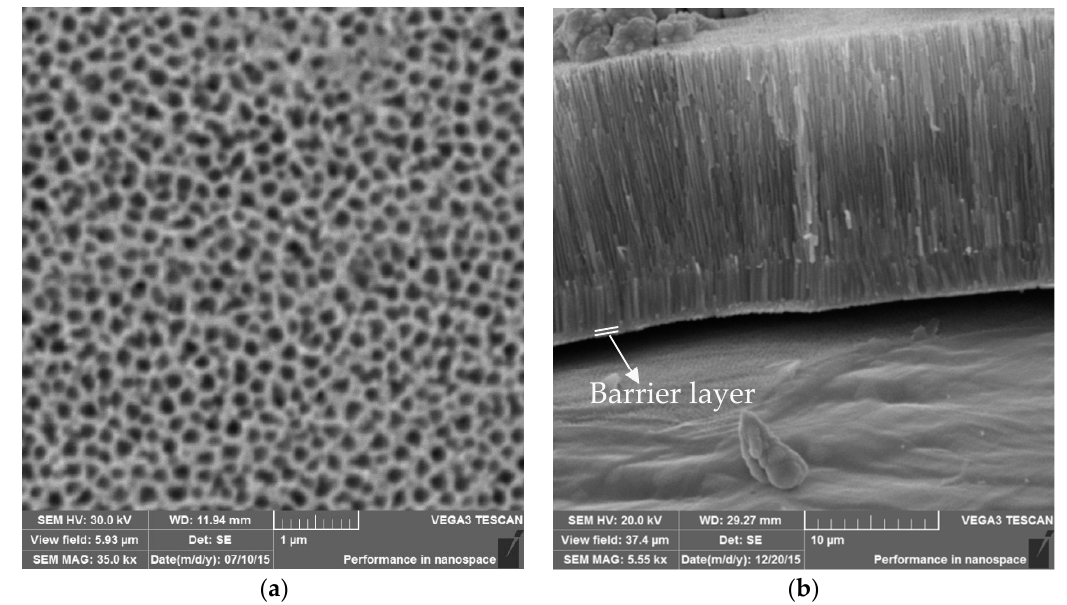
Figure 2. Electron micrograph of anodic alumina film: ( a ) Surface and ( b ) Cross.